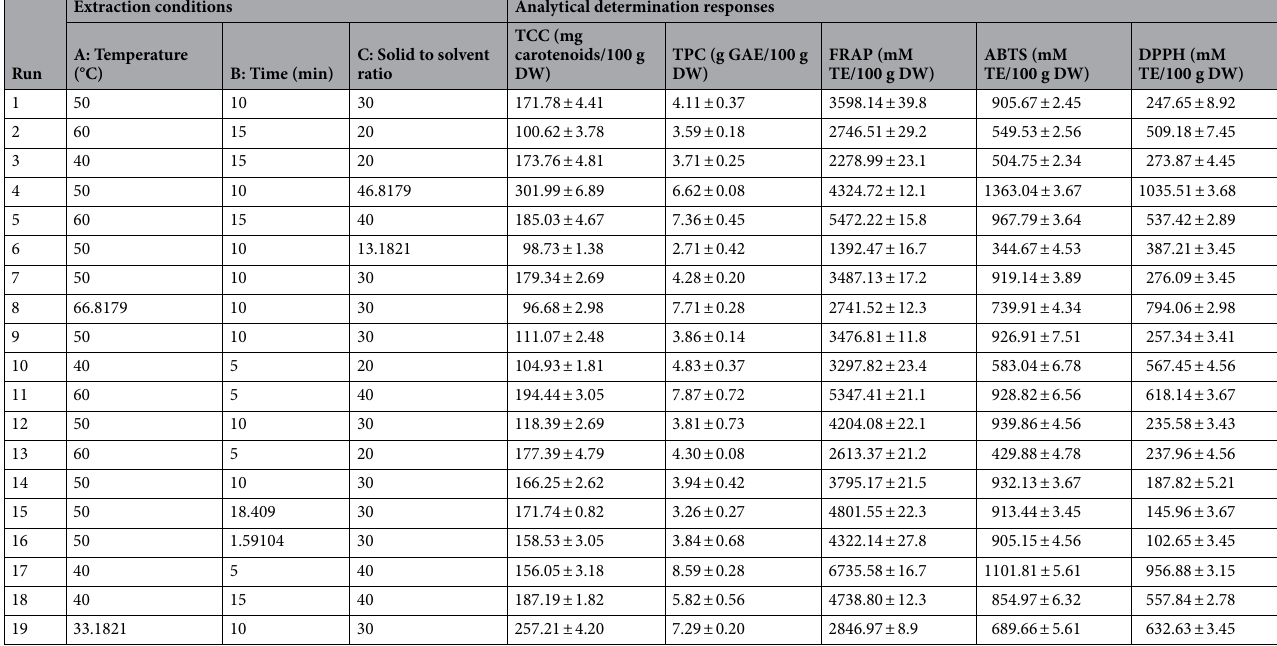
Table 4. Analytical results of the carrot extracts obtained under different conditions of MAE (R-CCD response analysis) (Study